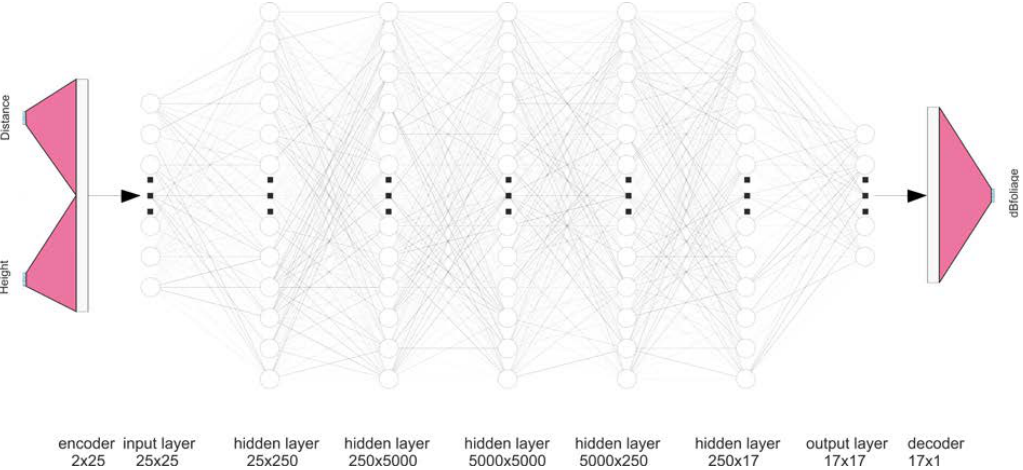
Figure 3. Schematic of the Deep Learning Model for the estimation of attenuation from distance and height.